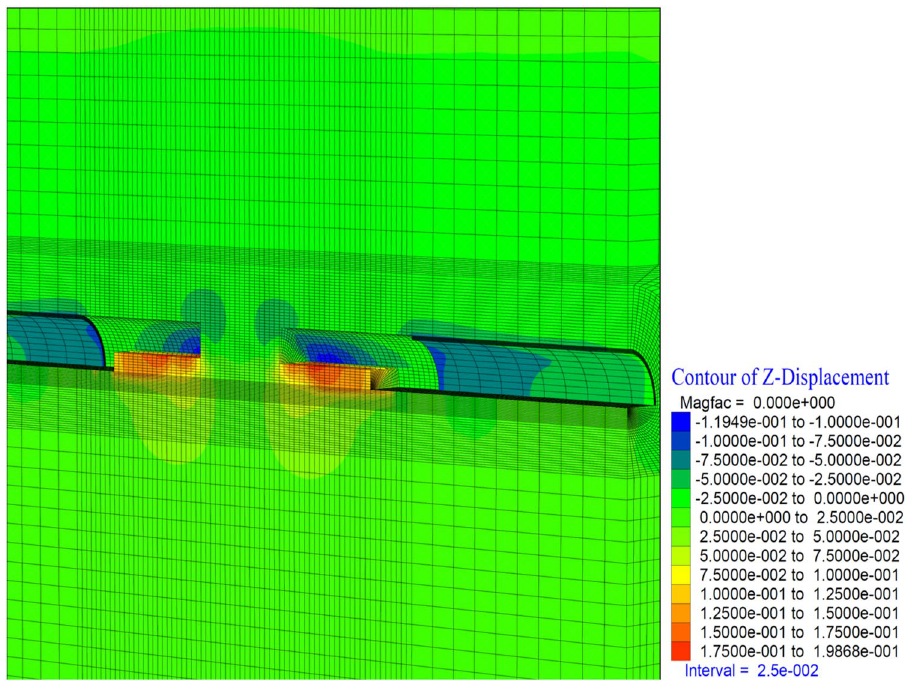
Figure 19. Z displacement in stage 26.